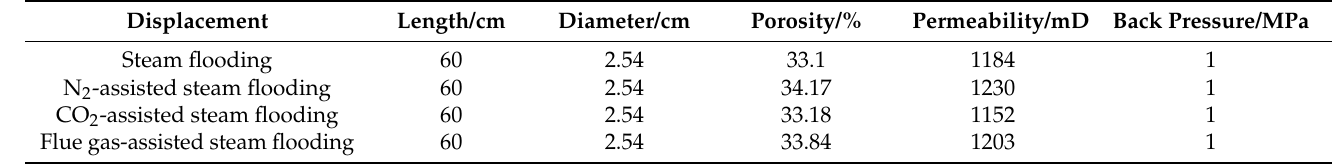
Table 1. Parameters of the sandpack used in the flooding experiment.